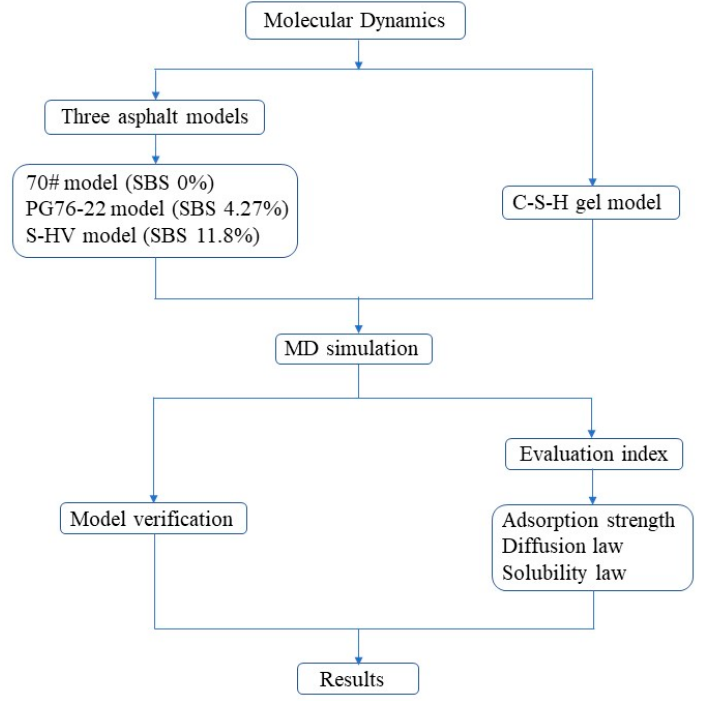
Figure 9. Research methods and technical workflow.